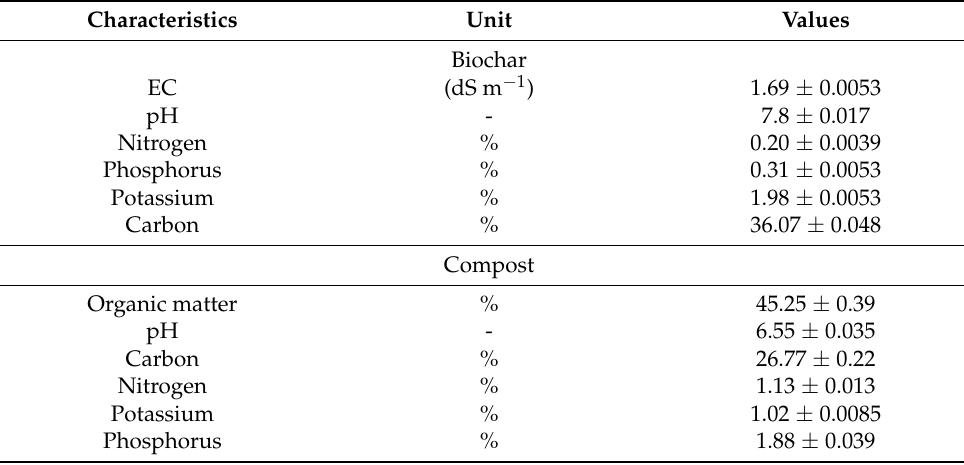
Table 1. Physical-chemical parameters of organic amendments and soil used for pot trial. Table 1. Physical ‐ chemical parameters of organic amendments and soil used for pot trial. Characteristics